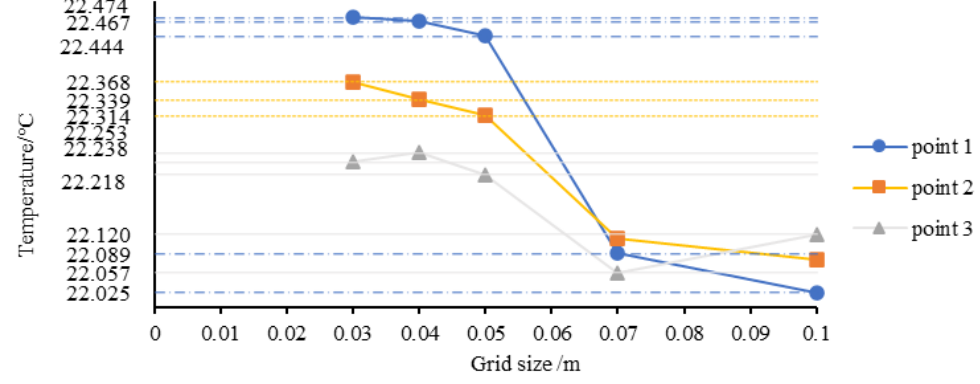
Figure 6. Grid independence verification results.